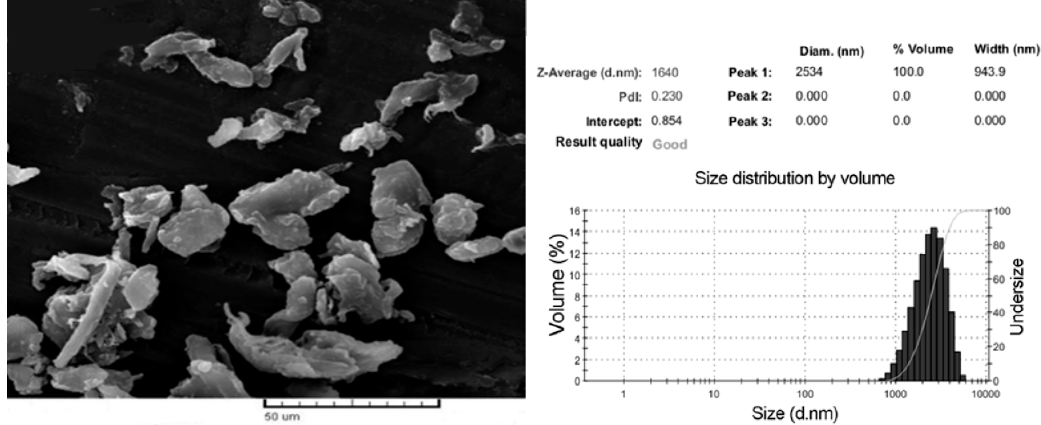
Figure 1. Morphology and size distribution of carbon microparticles.